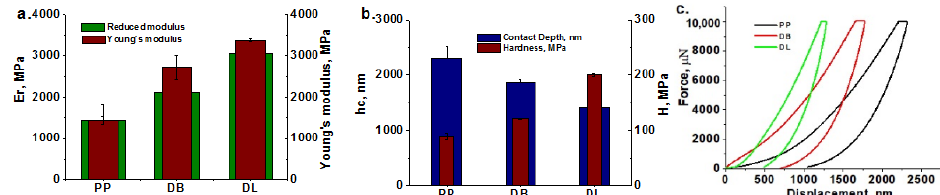
Figure 13. Reduced modulus vs. Young’s modulus ( a ) hardness ( b ) and load–displacement plots ( c ) for PP and PP hybrid composites obtained from selected masterbatches.